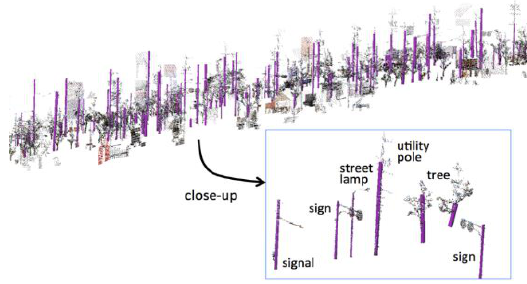
Figure 1. Extraction of high-density regions